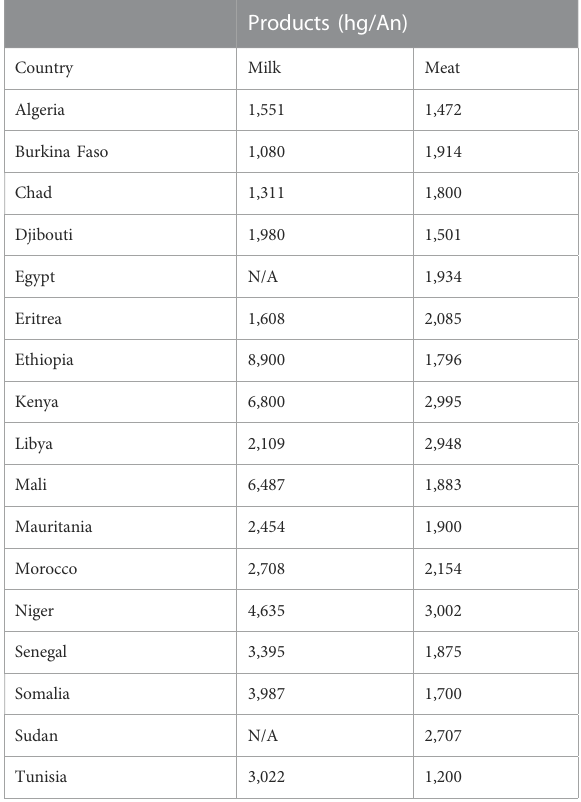
TABLE 2 Estimates of milk and meat production potentials of camels in